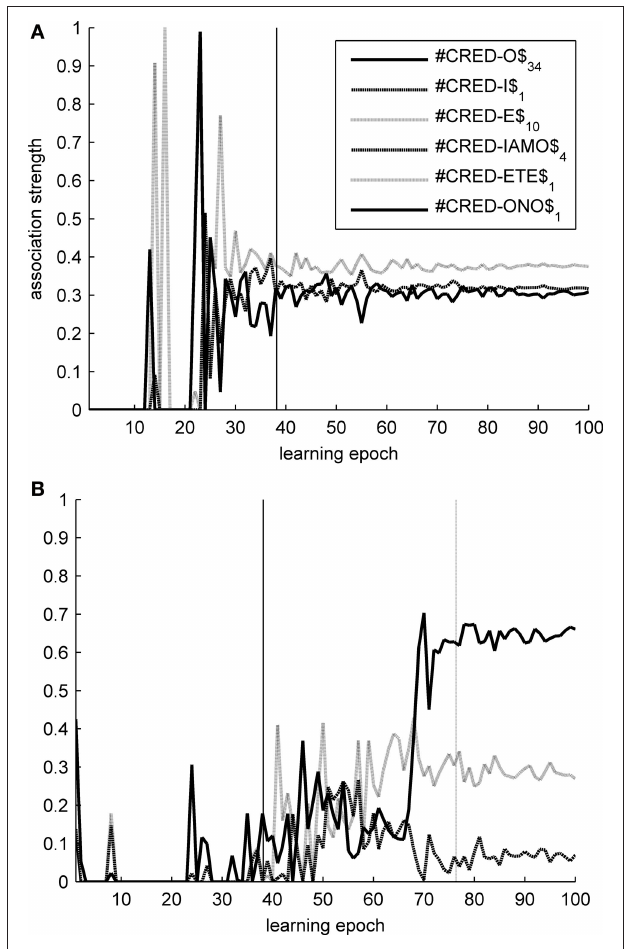
Figure 8 | Transition probabilities over morpheme boundaries in CreDere (‘believe’). (A) THSOM model; (B) T 2 HSOM